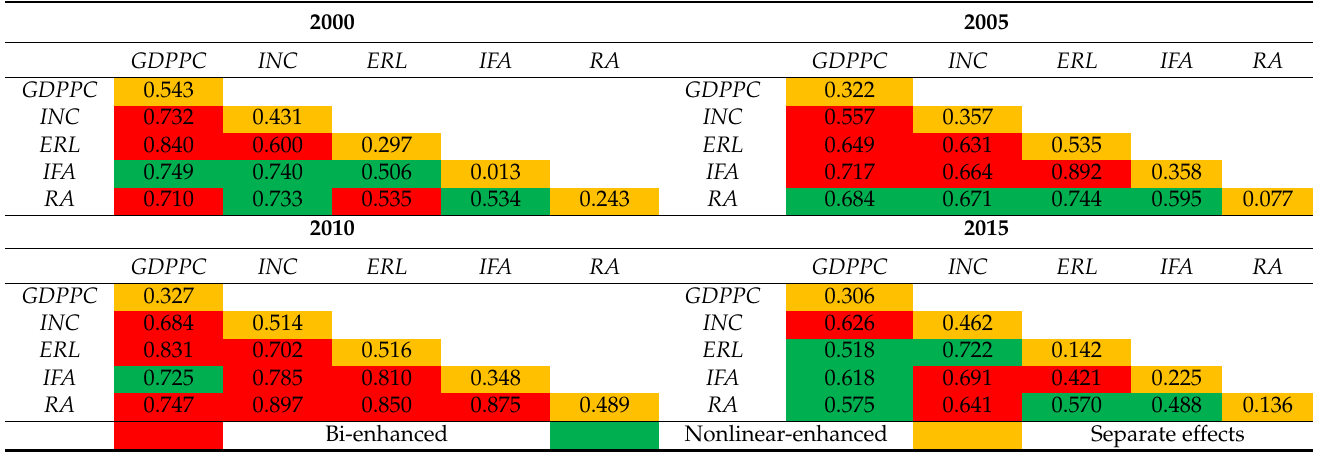
Table 4. Interaction of driving factors on rural energy poverty in 2000, 2005, 2010, and 2015.